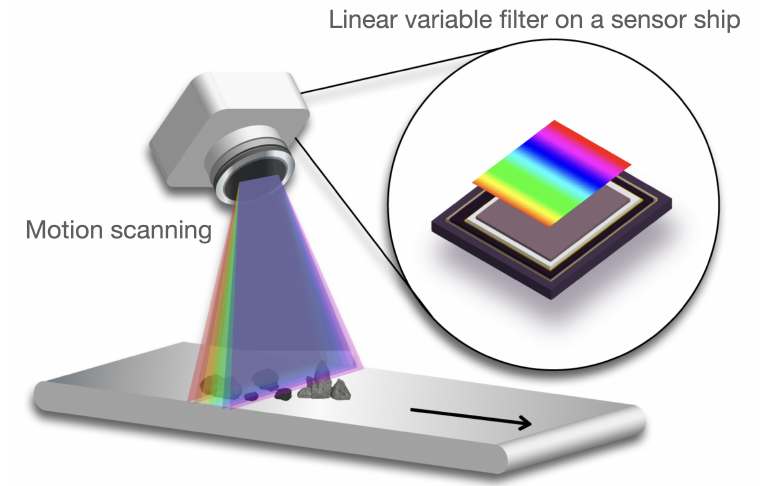
Figure 1. Linear variable filter motion scanning. An example of a linear variable filter on a sensor chip to achieve hyperspectral imaging. Imaging is achieved through motion-based scanning